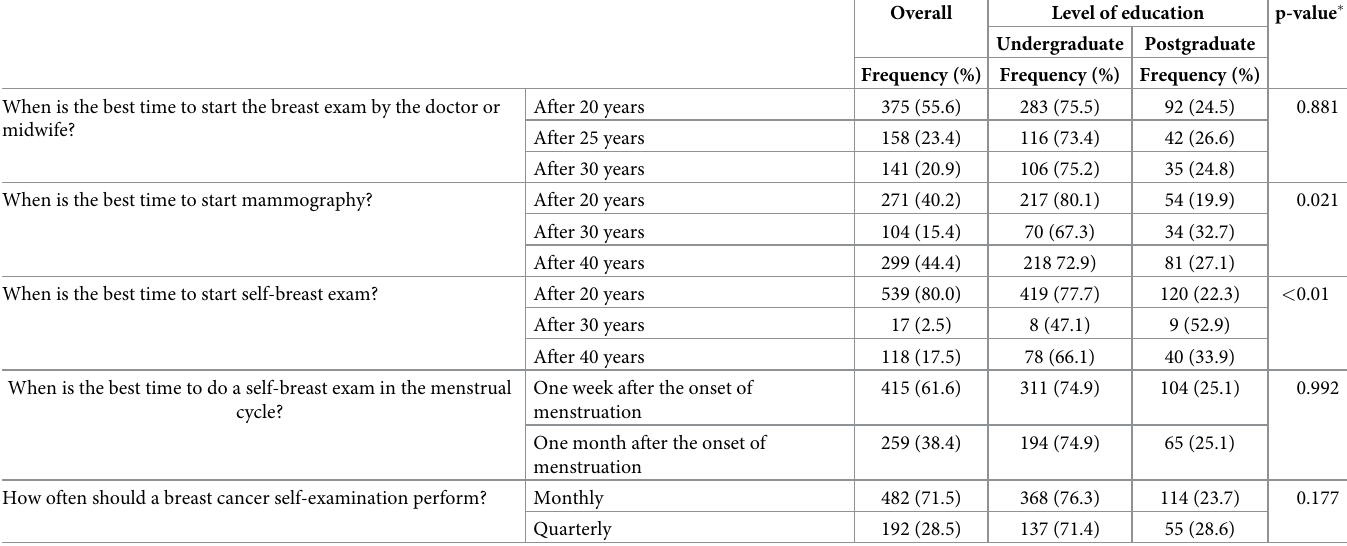
Table 6. Participant’s knowledge of best time to do breast examination for breast